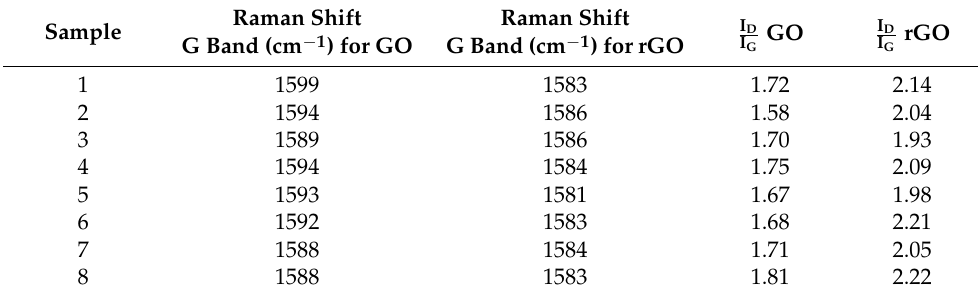
Table 6. Raman shift G band and I D